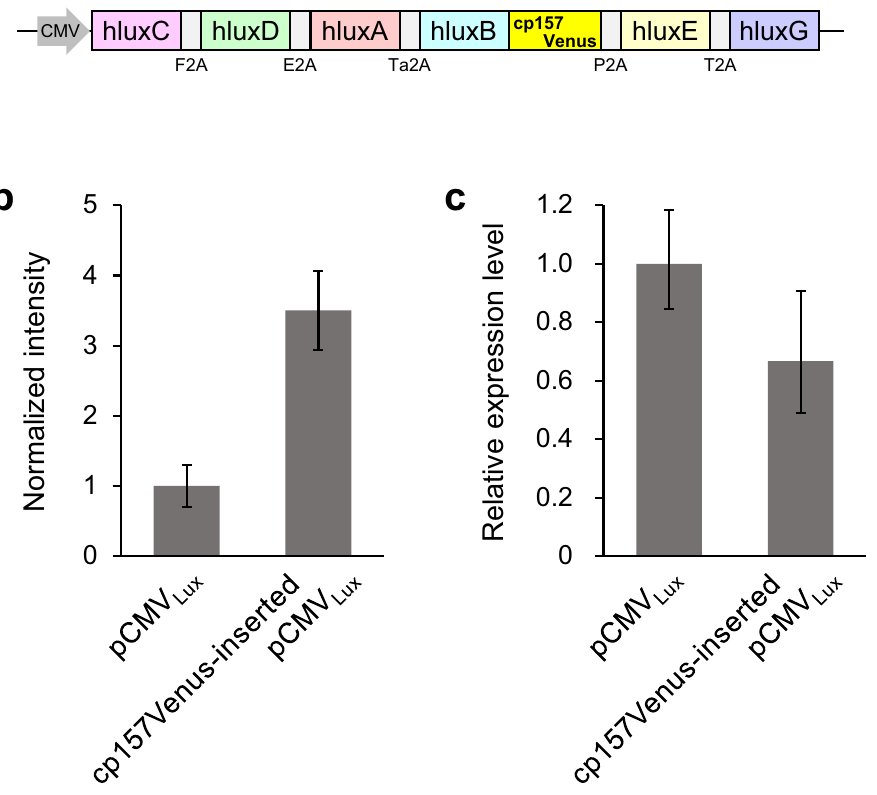
Figure 4. Autobioluminescence of HEK293T cells expressing pCMV Lux . ( a ) Schematic representation of cp157Venus-inserted pCMV Lux . ( b ) Luminescence intensities of HEK293T cells expressing the indicated constructs. Data are means ± SD of three different cell suspensions. ( c ) Relative quantitation of hluxB